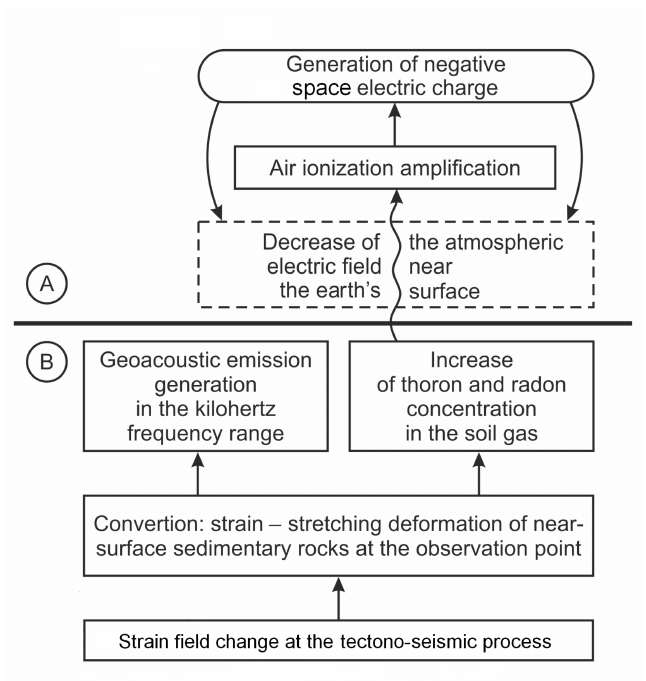
Figure 10. Scheme of formation of joint anomalies of high-frequency geoacoustic emission and atmospheric electric field in a seismically active region. A—near-ground air, B—near-surface sedimentary